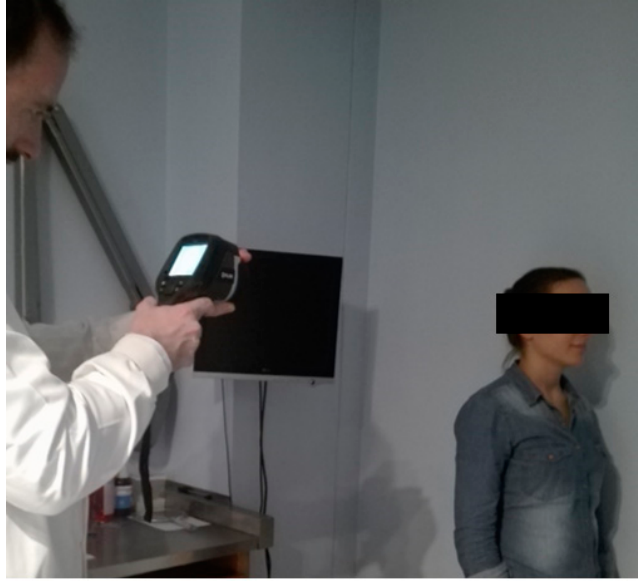
Figure 5. Recording the right lateral thermograms with the thermal imaging infrared camera, E60 FLIR.